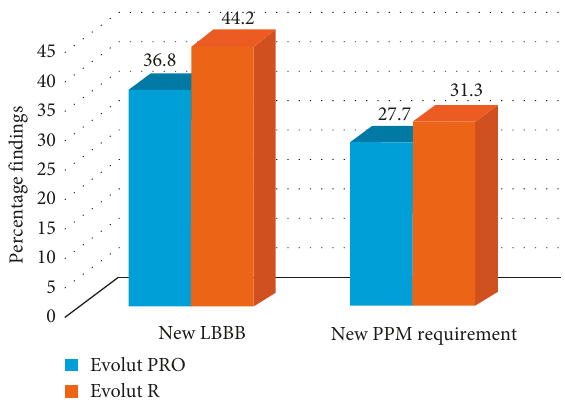
Figure 2: New left bundle branch block and pacemaker re- quirement. Legend: New electrocardiogram findings of left bundle branch block (LBBB) and new permanent percutaneous pacemaker (PPM) requirement in the patients implanted with CoreValve Evolut PRO and CoreValve Evolut R. There is no significant dif- ference between the two